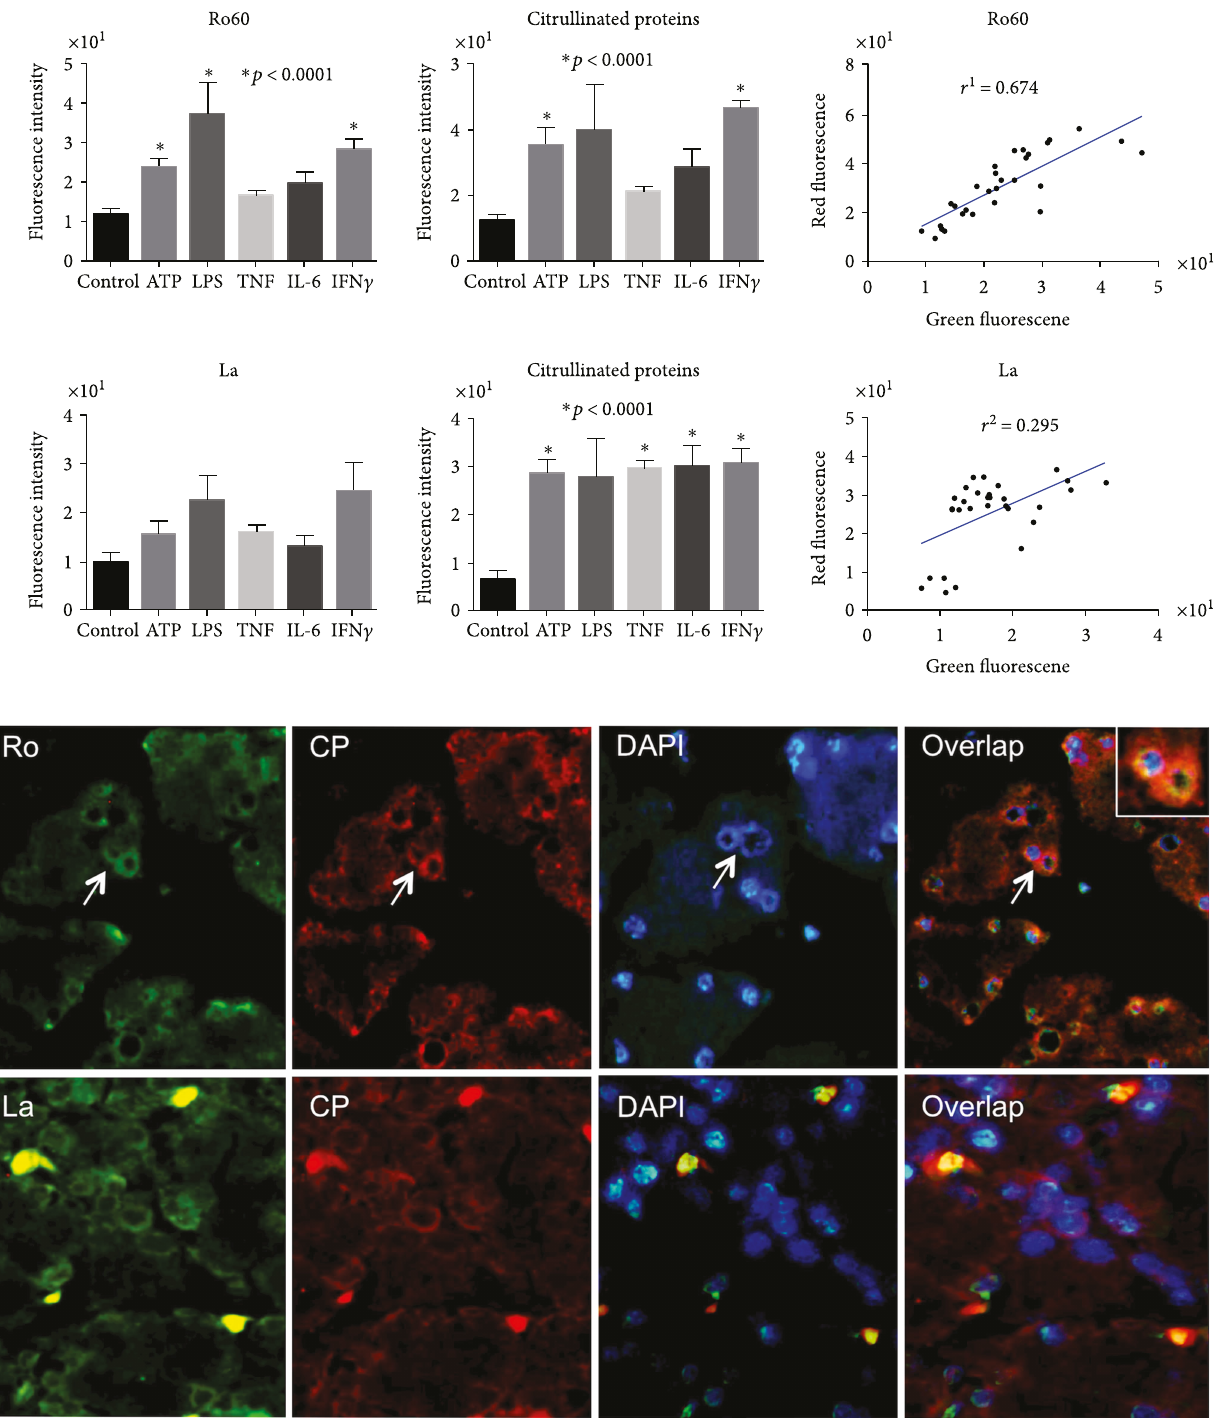
Figure 6: Double fl uorescence assays showing colocalization. Graphs show the fl uorescent expression of Ro60 and La ribonucleoproteins in response to di ff erent molecular triggers. A representative double fl uorescence assay of Ro and La (green) colocalization with citrullinated proteins (red). Nuclei are counterstained with DAPI (blue). The green and red fl uorescence was analyzed in speci fi c areas of colocation indicated by arrows and magni fi ed in boxes, and the colocalization was analyzed by a regression analysis, which resulted with r 2 of 0.674 for Ro60 meanwile 0.295 for La ribonucleoprotein. The asterisk on the top bars means signi fi cant di ff erences from control ( p < 0 0001 , Student t